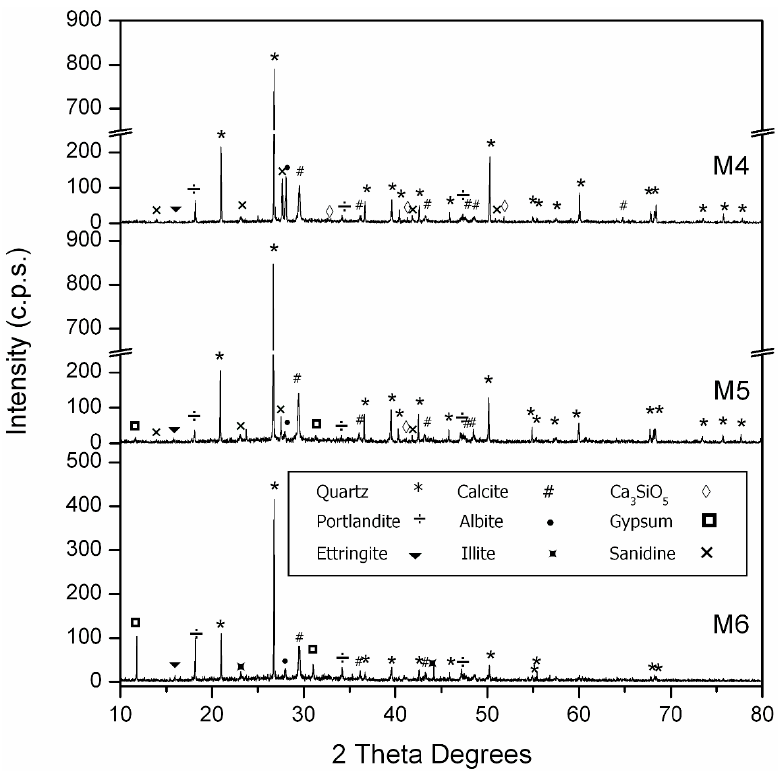
Figure 7. Powder X-ray diffraction (PRXD) diagrams of Family-2’s mortars.